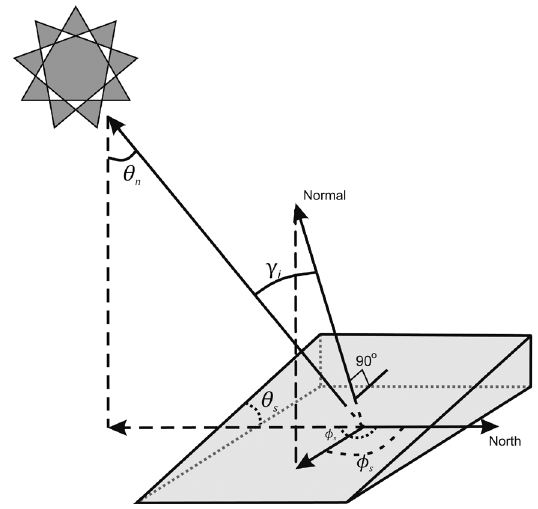
Fig. 3. Geometric illustration shows all angles involved in calculating the incidence angle between normal to the ground and sunrays in slopped area. Image reproduced from Riaño et al.